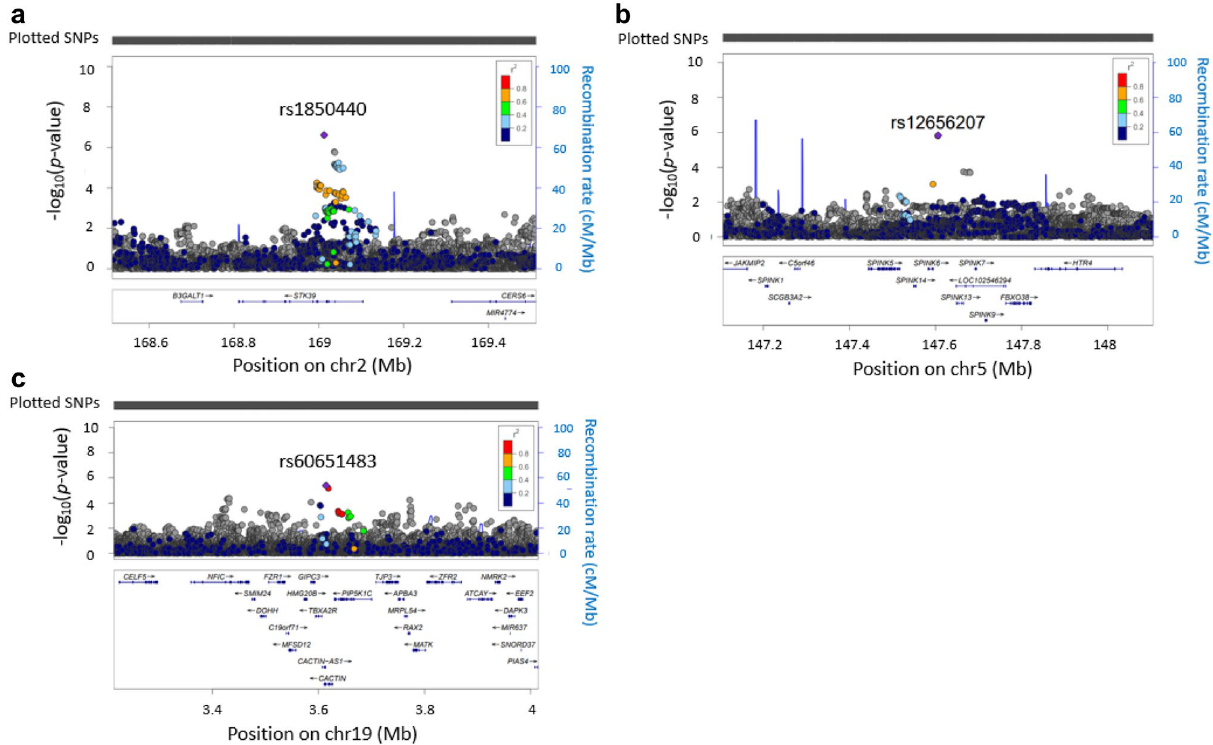
Figure 2. Regional plots for 3 variants with replicable odds ratios. Regional plots of susceptibility loci based on an association analysis in the GWAS. The purple dots indicate the focused variants. ( a ) Regional plot for rs1850440, ( b ) regional plot for rs12656207 and ( c ) regional plot for